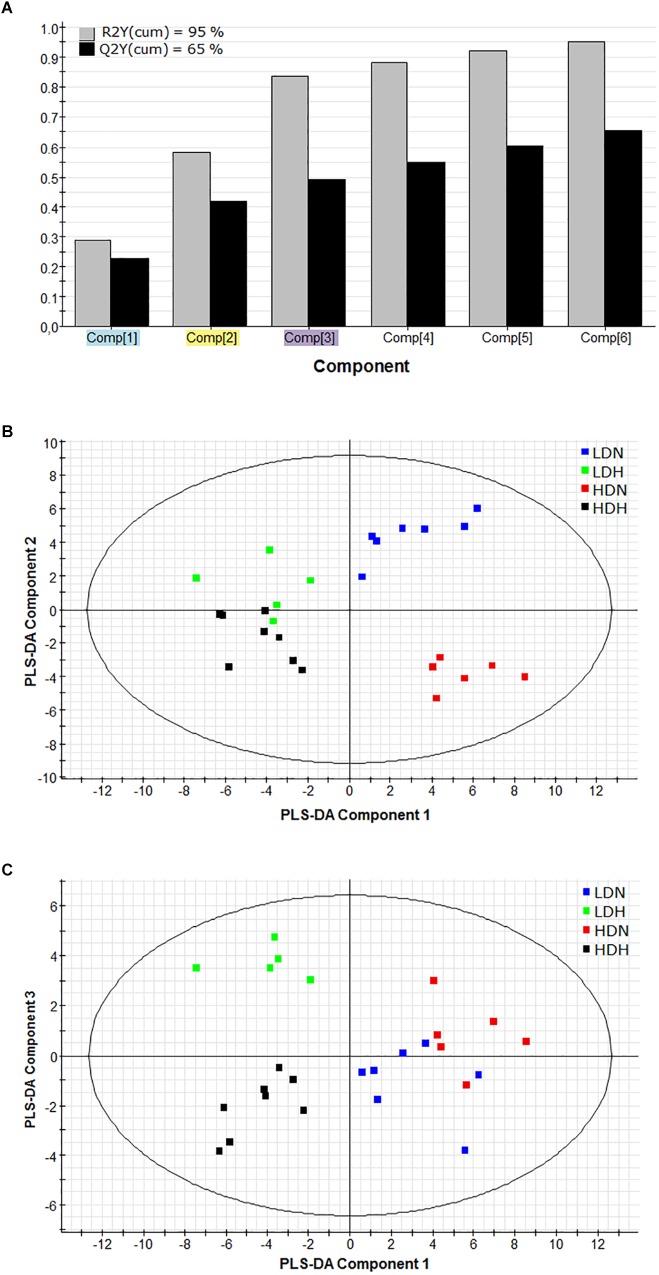
(A) Graphical representation of the goodness-of-fit of the PLS-DA model. (B) Two-dimensional PLS-DA score plot representing the distribution of the samples between the first two components in the model. (C) Two-dimensional PLS-DA score plot representing the distribution of the samples between the first and third components in the model. R2(cum), explained variance; Q2(cum), predicted variance; LDN, low density normoxia; LDH, low density hypoxia; HDN, high density normoxia; HDH, high density hypoxia.